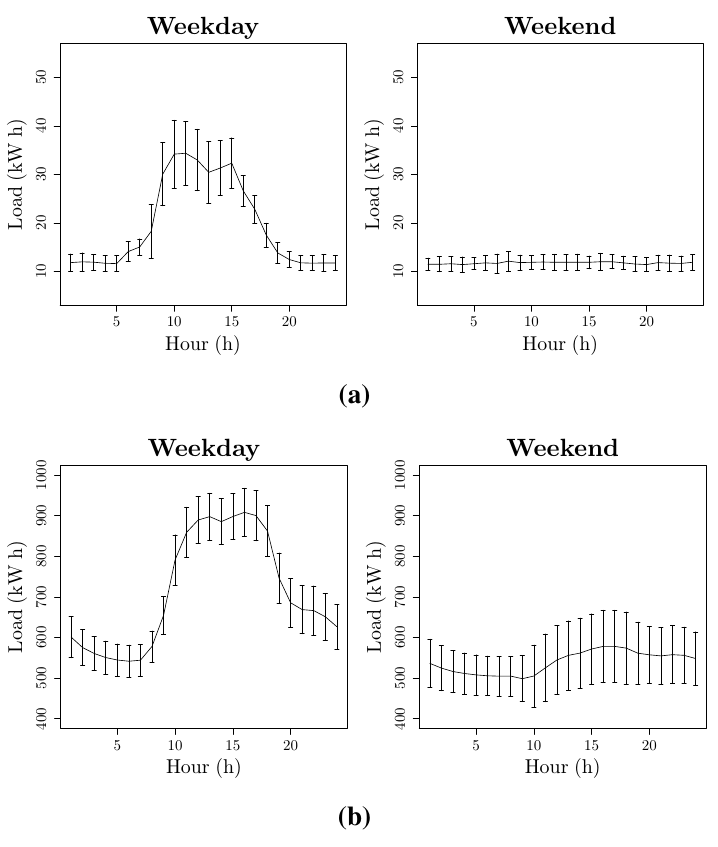
Figure 2. Typical load for the dataset with two day-types. Average daily load ( kW h ). Error bars denotes ± σ . ( a ) Dataset c 59 ; ( b ) Dataset ashrae